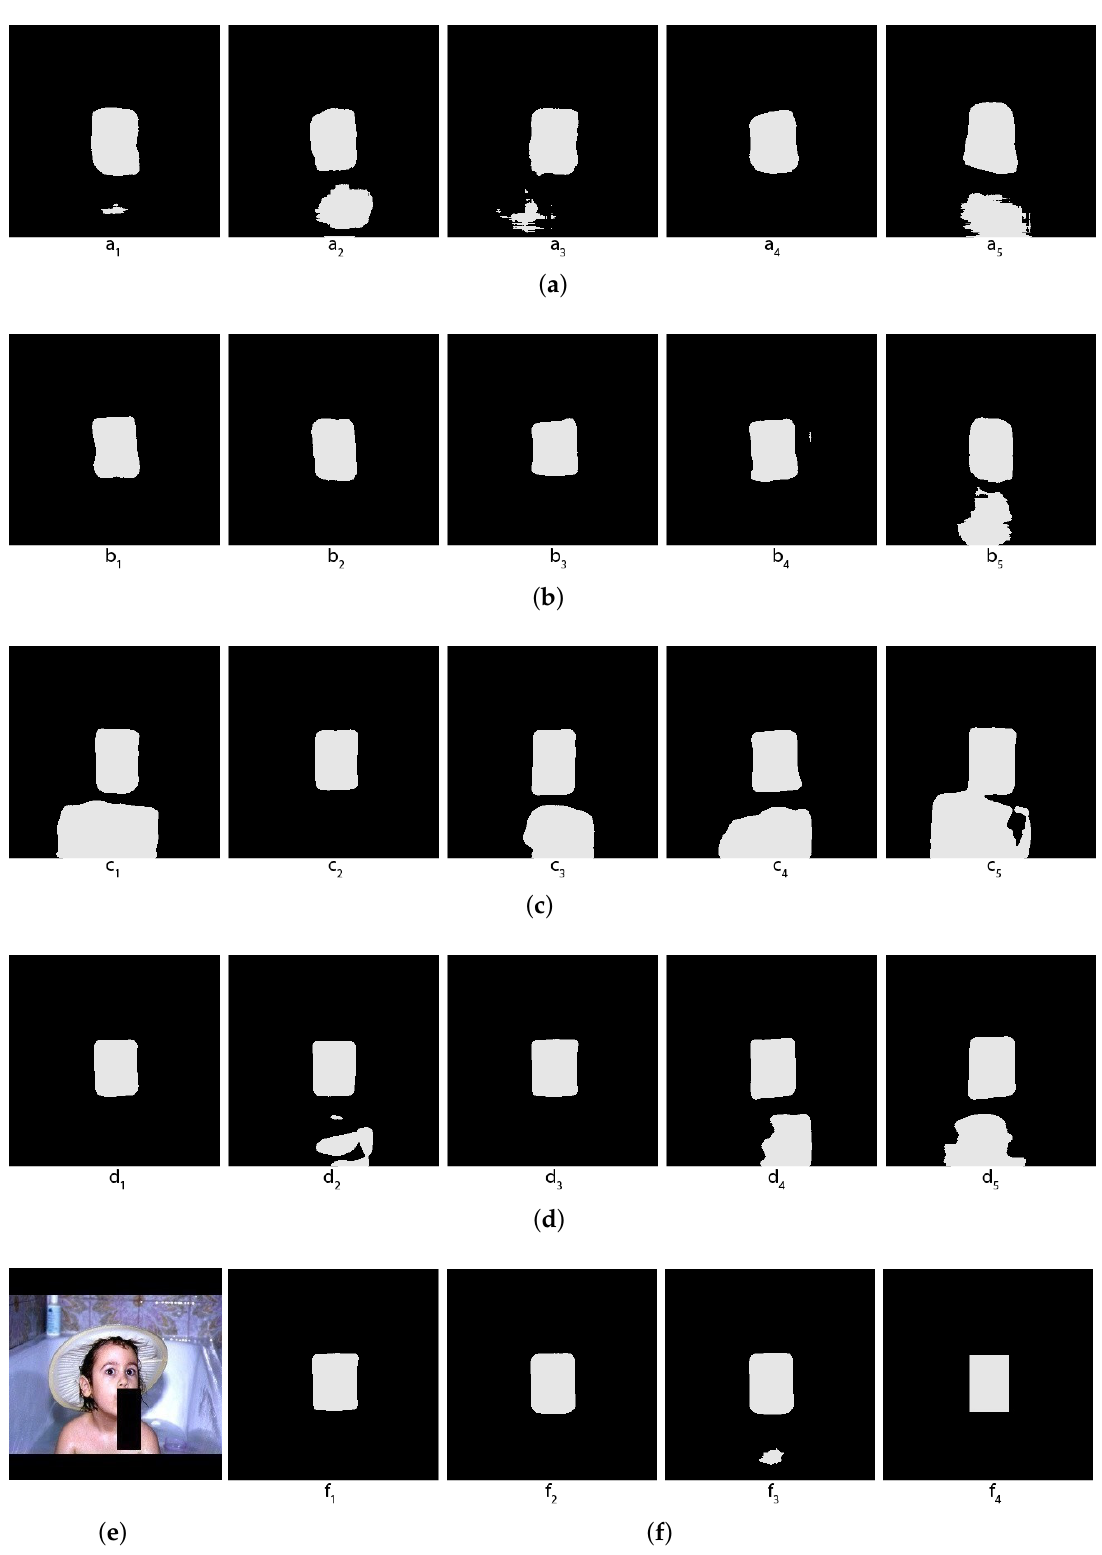
Figure 7. Comparison of voting methods for human faces—The first example. ( a ) Predictions of the first 5 folds (with Mobilenet); ( b ) Predictions of the last 5 folds (with Mobilenet); ( c ) Predictions of the first 5 folds (with EfficienNet); ( d ) Predictions of the last 5 folds (with EfficienNet); ( e ) Original image; ( f ) f 1 : Topological voting, f 2 : Hybrid voting (threshold = 2), f 3 : Arithmetical voting, f 4 : True Mask.